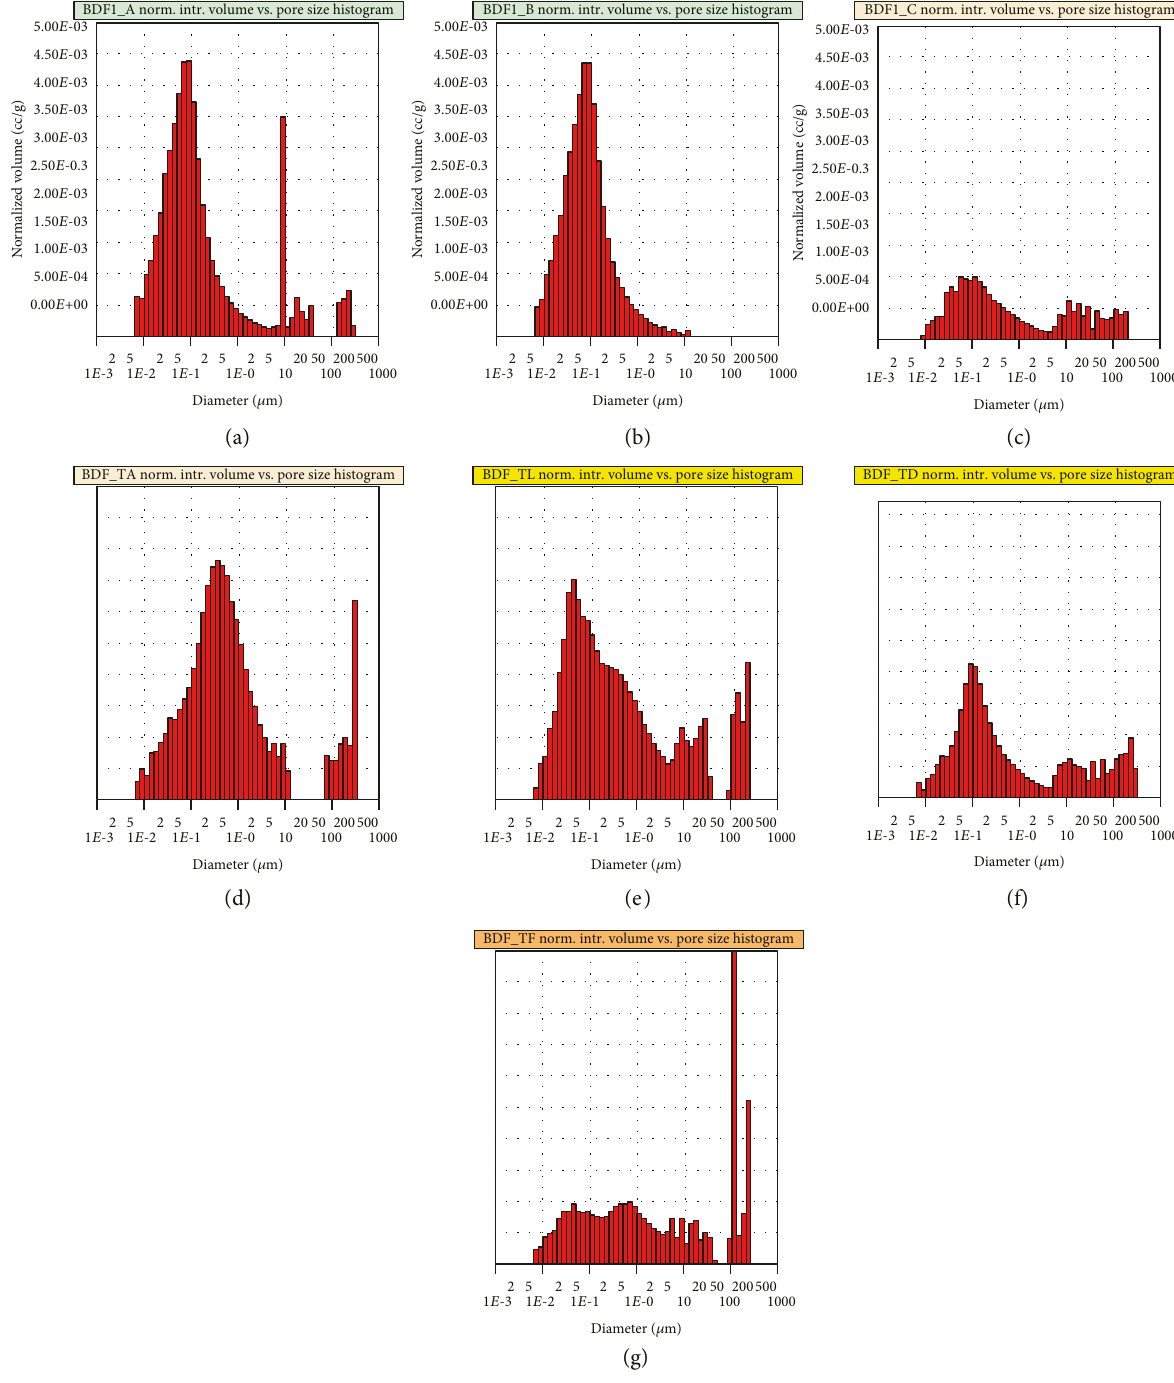
Figure 7: Results of Hg-intrusion pore size distribution analysis of host rock. Color in title denotes grain